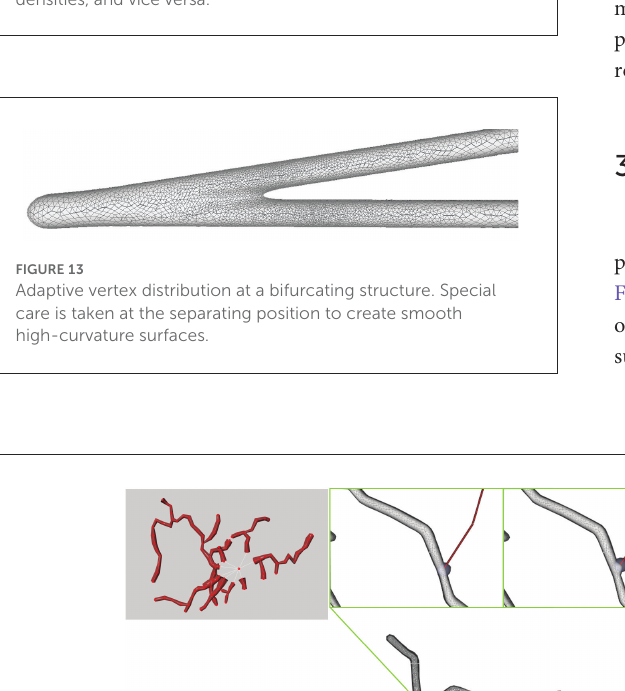
FIGURE12 Membrane surfaces with adaptive edges for different thickness: surfaces with larger radius are created with vertices of lower densities, and vice versa.